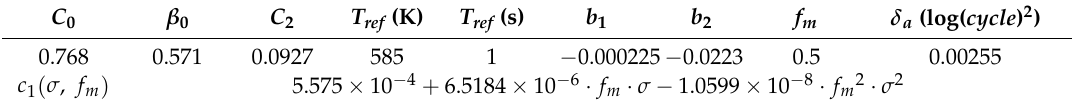
Table 5. The coefficients of the explicit formulation for stainless steel